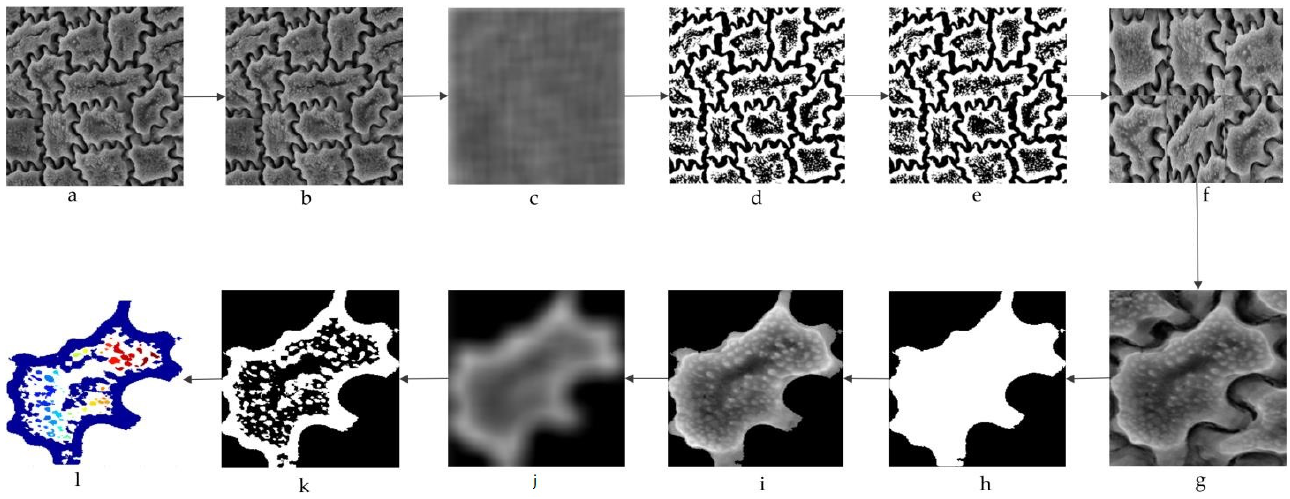
Figure 10. Data preprocessing of the seed coat pattern. ( a ) Input image, ( b ) grayscale image, ( c ) threshold using adaptive thresholding, ( d ) binary image, ( e ) labeled image ( f ) and cropped image, ( g ) separated cropped image, ( h ) masked image, ( i ) grayscale image, ( j ) binary image obtained using an adaptive threshold, ( k ) binary image, ( l ) and colored image.